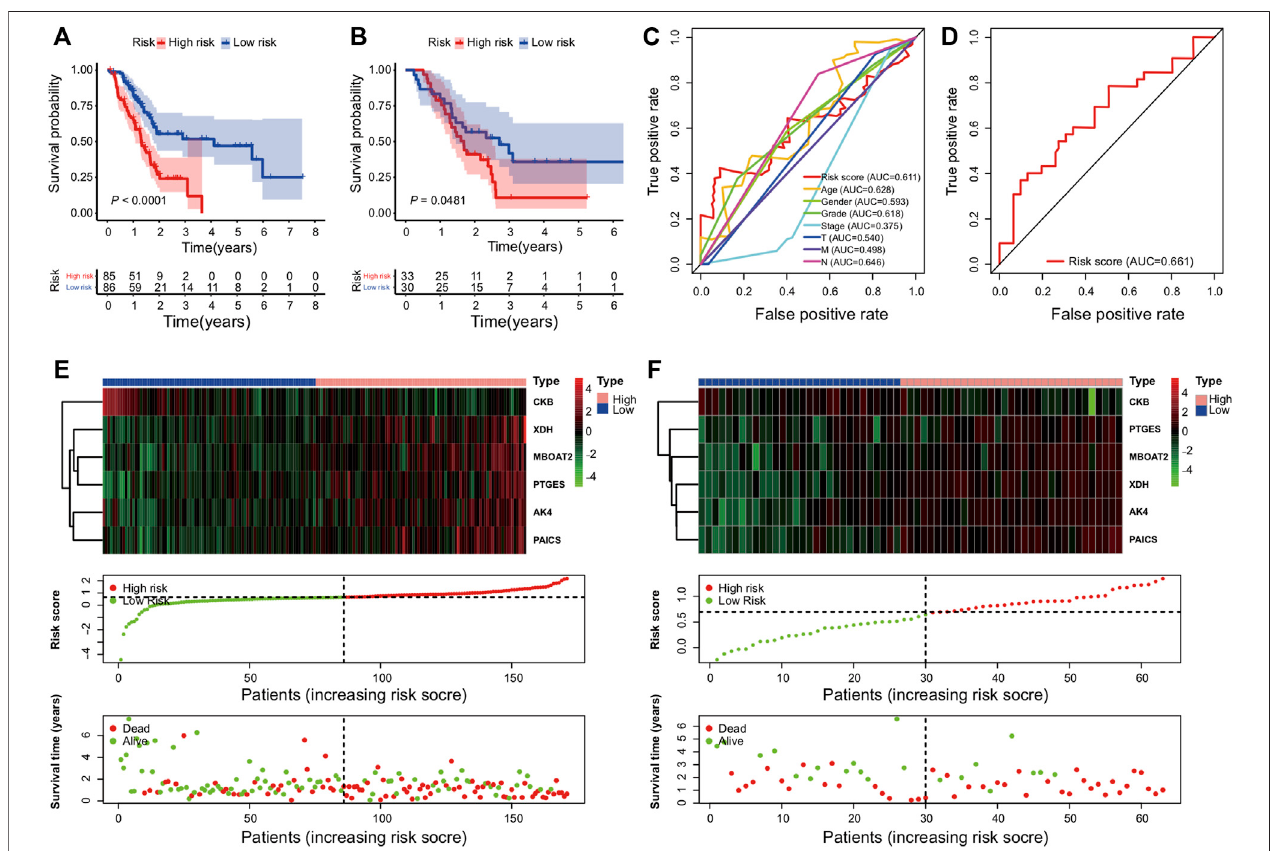
FIGURE 2 | Establishment and validation of the metabolic genes prognostic risk model: (A,B) Kaplan – Meier curve analysis comparing the OS between patients in high-risk and low-risk groups in training and validation cohorts; (C,D) survival prediction ROC curves of the risk model and other clinical indices from two cohorts; (E,F) from top to bottom, there are the six PDEMRG expression patterns, risk score distribution of patients, and their survival status scatter plots in the training and validation cohorts.